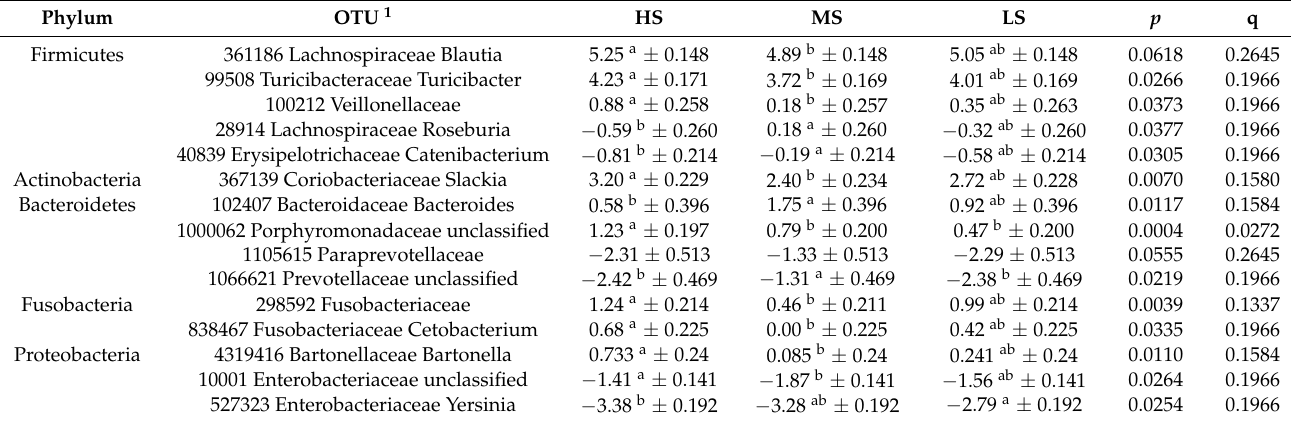
Table 6. Estimated means Operational Taxonomic Unit (OTU) ( ± Standard Error, expressed in the Centered Log-Ratio scale) of dogs fed diets produced at high, medium and low shear (HS, MS and LS, respectively). Phylum OTU 1 HS MS